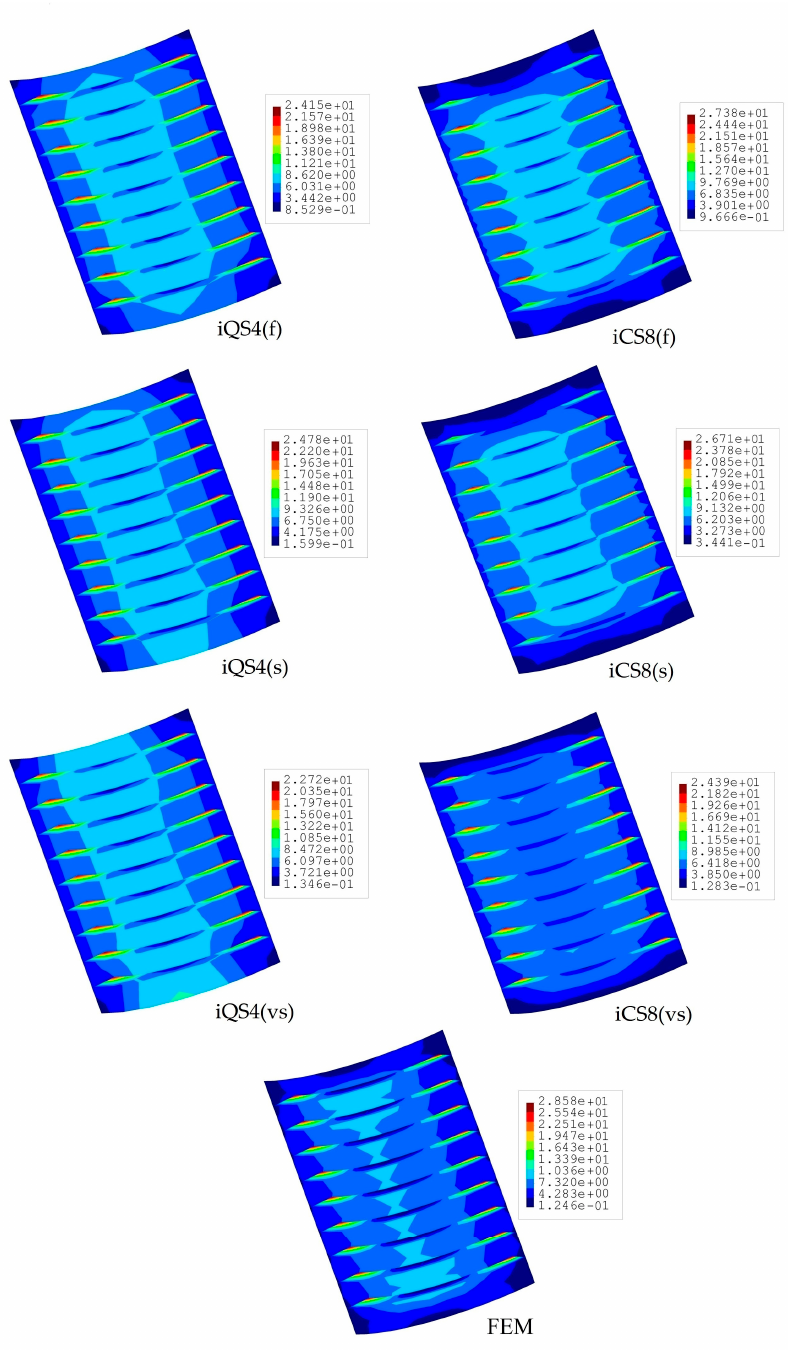
Figure 14. Contours of von Mises stress [MPa] for stiffened curved plate.